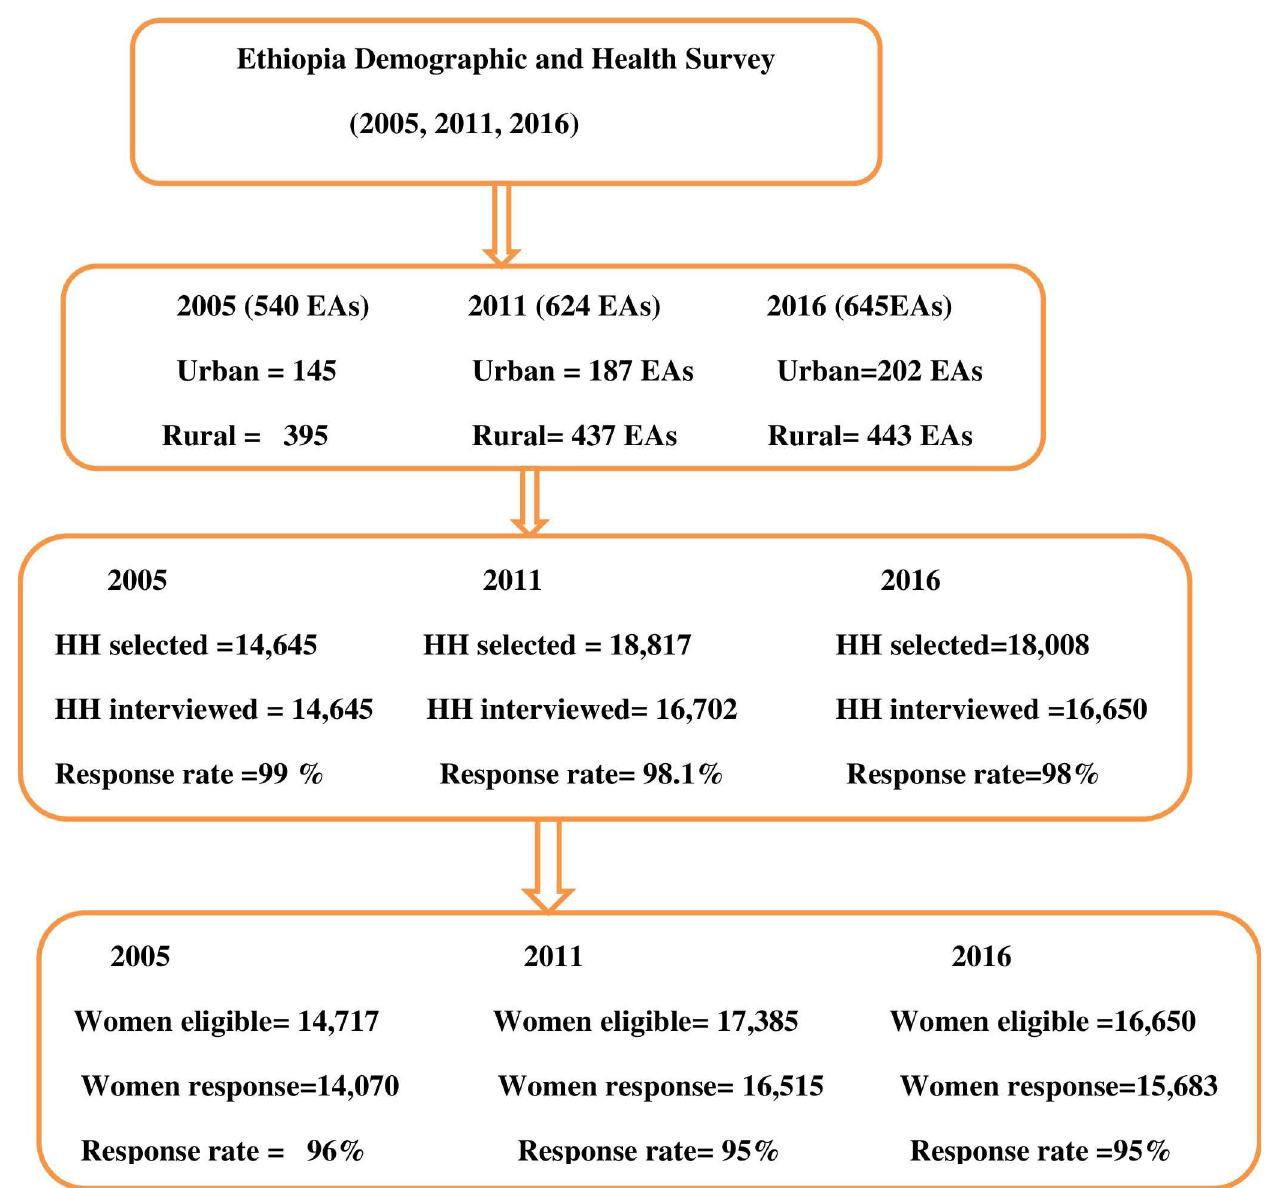
Fig 1. Schematic presentation of sampling technique of EDHS among women of reproductive age in Ethiopia from 2011–2016.